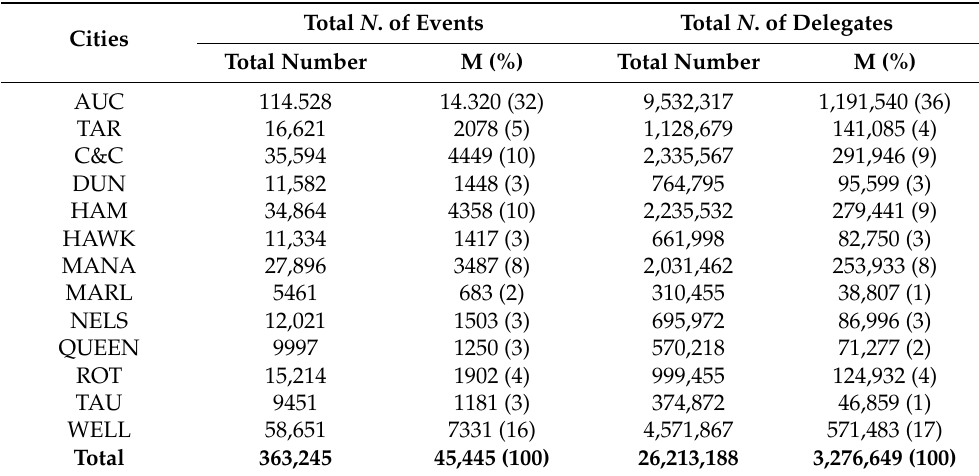
Table 1. Total volumes of event data for eight years